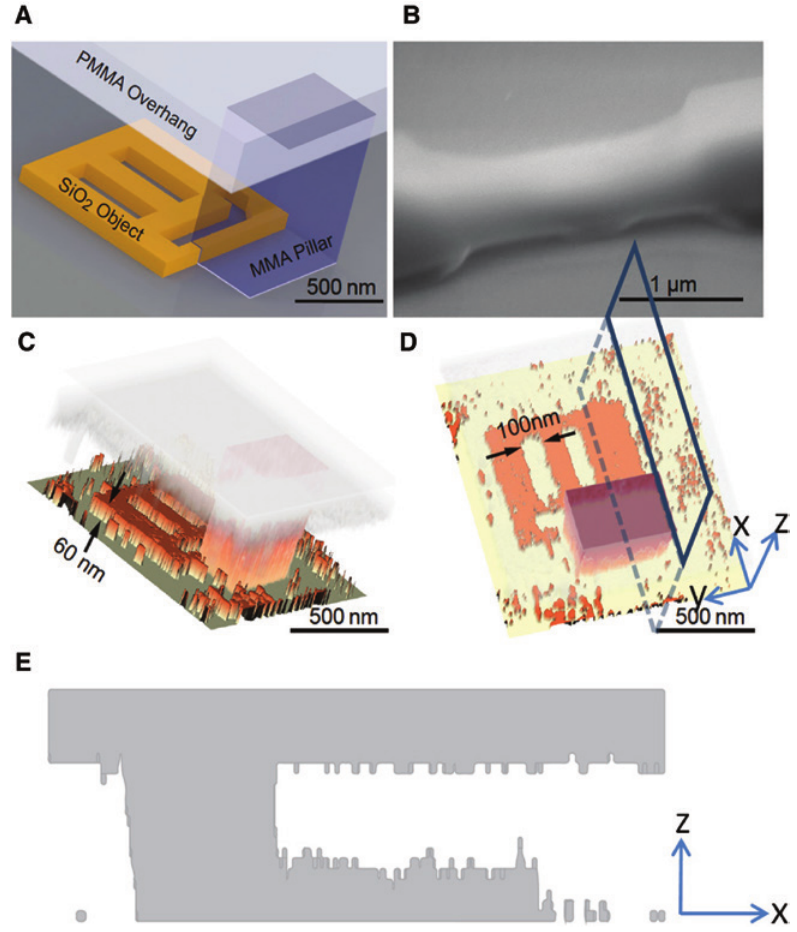
Figure 4: Imaging of topology of a three-dimensional shape with internal geometry. (A) Schematic of the fabricated structure consisting of a silicon dioxide layer patterned onto a smiley face and an overhanging PMMA structure. The thick PMMA overhang (light gray), supported by the MMA post (blue) roofs the smiley SiO face (yellow). (B) SEM image of the 2 structure on which a small gap can be seen, but the top PMMA layer obscures the underlying smiley face. The MMA pillar can be distin- guished in the middle. (C) Side view of the PBM reconstruction of the sample showing clearly the smiley (orange) face structure as well as the overhang roof (gray) supported by a thick post (orange). The image was reconstructed from 250,000 frames with 3 ms acquisition each and errors in determining height at certain positions are visible around the smiley face. (D) Top-down view of the sample showing that PBM was able to image 100 nm feature within the overhung structure. The rectangle represents a cutting plane which shows how the cross section in (E) was obtained. The dashed line and the solid line indicate the portion of the cutting plane that goes “through” and above the sample, respectively. (E) Sagittal (XZ) cross section of the reconstructed area where the cut plane is shown in (D). The gray areas correspond to the places where the sample is present (i.e. filled PMMA, while the white ones represent an empty space around the